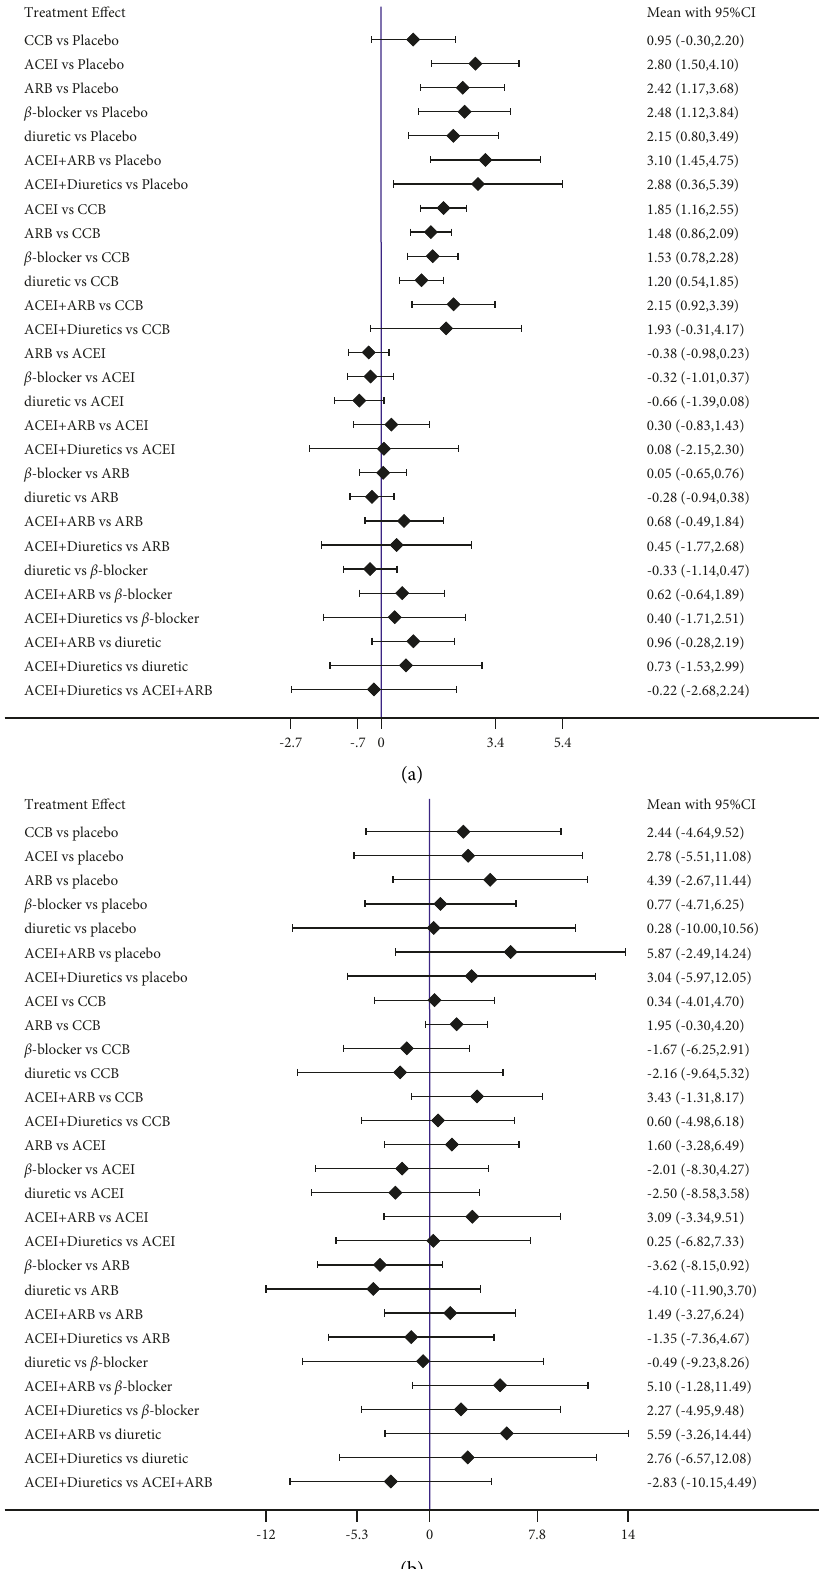
Figure 11: Subgroup analysis of forest plots for the assessment of age in FMD. (a) Age ≤ 55 years, (b) aged ＞ 55 years). ACEI: angio- tensinconverting enzyme inhibitors, ARB: angiotensin receptor blocker, CCB: calcium channel